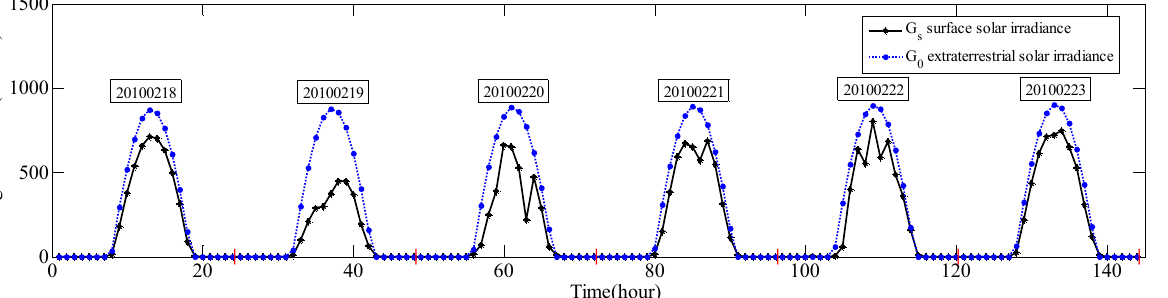
Figure 3. Original value, normalized value and NDD of solar irradiance; ( a ) Original and normalized value of solar irradiance; ( b ) Normalized discrete difference of solar